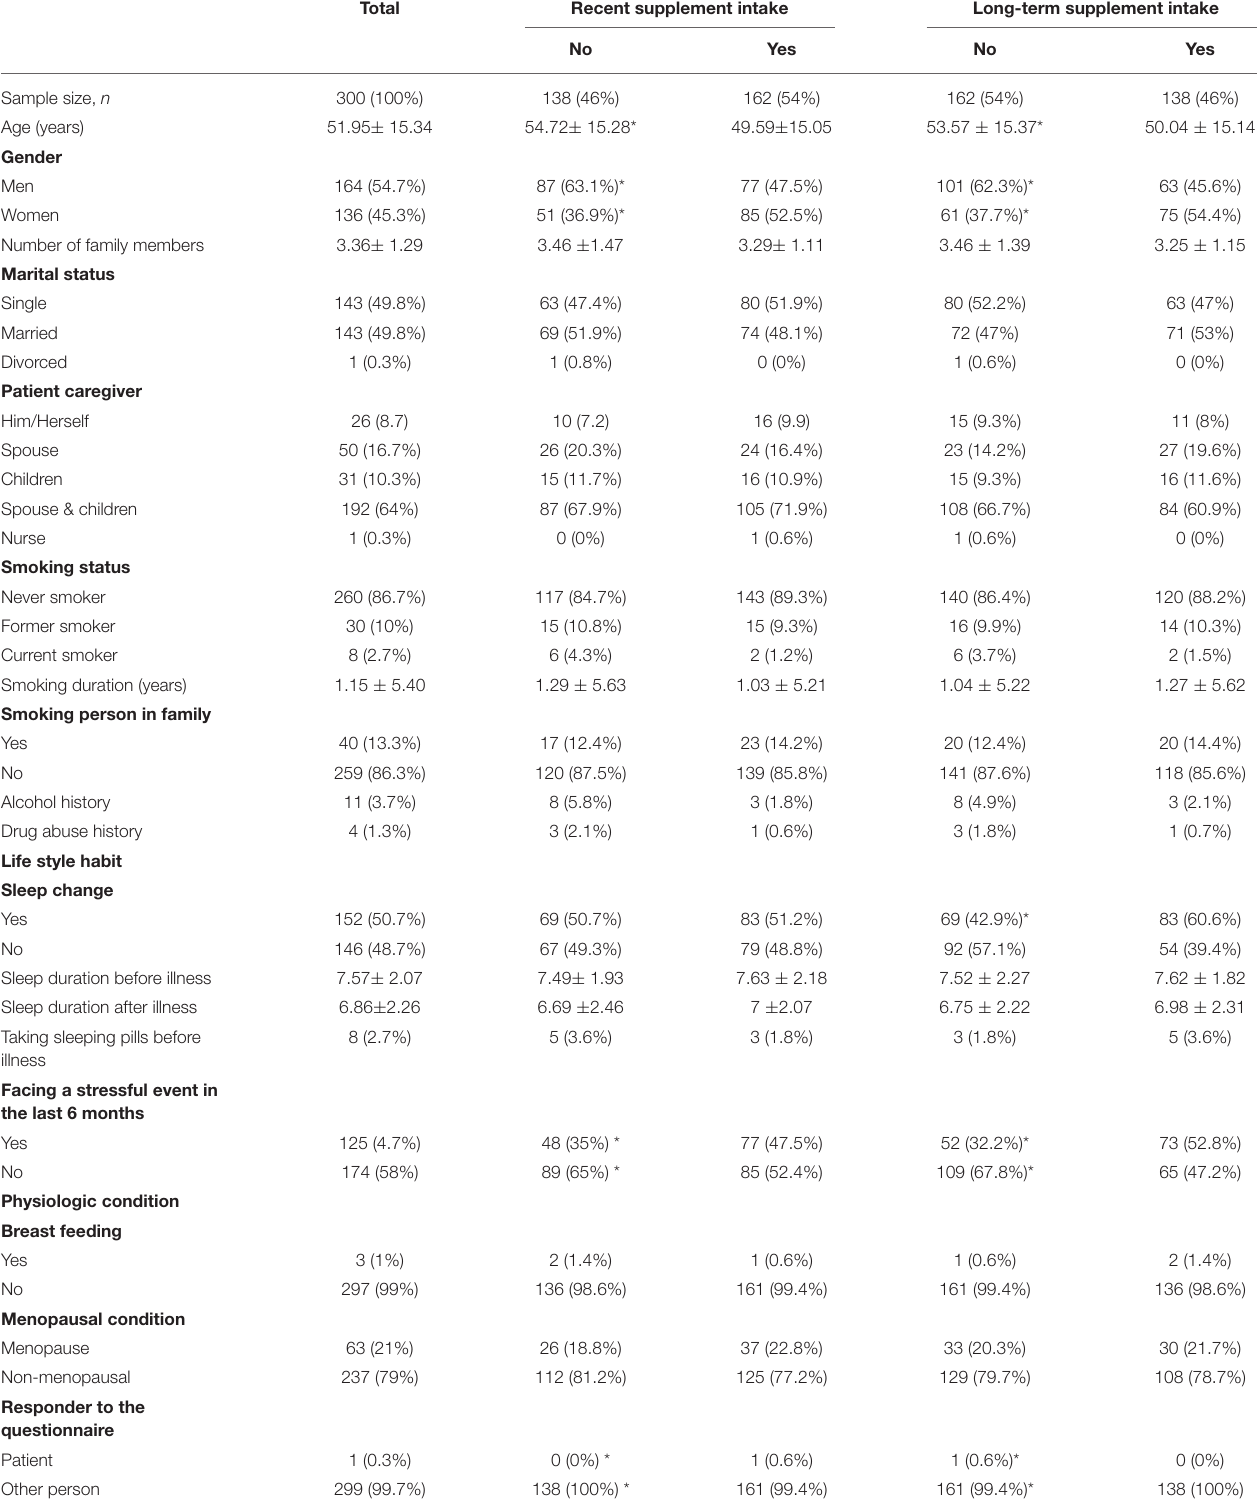
TABLE 1 | Sociodemographic characteristics of patients with COVID-19 according to recent, long-term, and during hospitalization intakes. Total Recent supplement